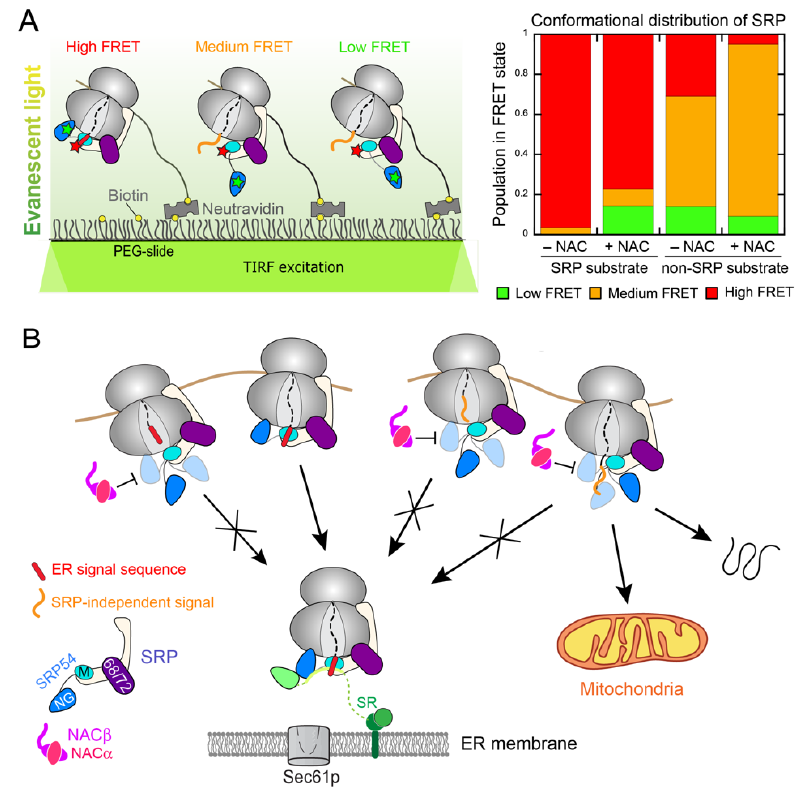
Figure 5. NAC enhances the specificity of ER targeting by regulating the conformation and activity of SRP. ( A ) Single-molecule FRET (smFRET) measurements show how NAC remodels the conformation of SRP on the ribosome. Left panel: schematic of the smFRET experiment. A FRET dye pair was incorporated on SRP54-NG and SRP19 to detect the Proximal conformation of SRP most active in SR recruitment. SRP was recruited to RNCs immobilized on the microscope slide surface, on which it can sample distinct conformational states that generate different FRET efficiencies between the dye pair. Right: summary of the conformational distribution of SRP on signal sequence-containing and signal-less ribosomes. NAC reduces the population of SRP in the high FRET state on signal-less ribosomes, directly demonstrating NAC allosteric regulation of SRP. Adapted from [56]. ( B ) Model of the mechanism by which NAC improves the targeting specificity of SRP. NAC (magenta) inhibits SRP from adopting the Proximal conformation on both short-chain RNCs and on ribosomes that expose a non-ER targeting signal, thus delaying the onset of ER targeting and preventing promiscuous targeting to the ER.